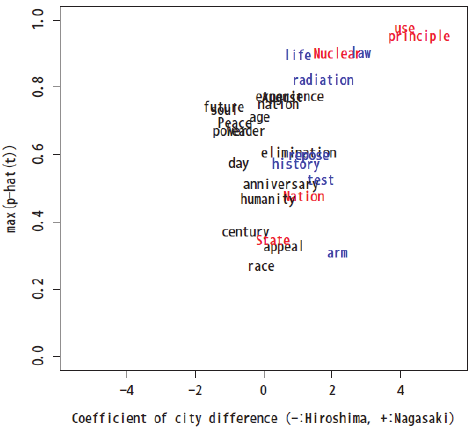
Fig. 23. Scatter plot of keyword's appearance by cluster in 2007